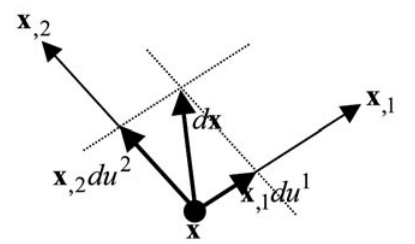
Figure 4 The differential vector d x as a linear combination (equation